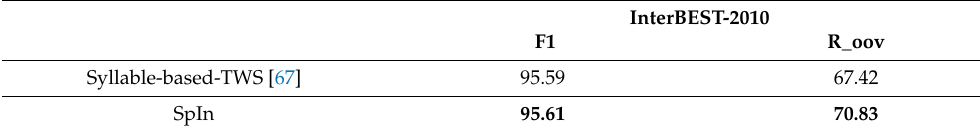
Table 6. Comparison between SpIn and previous state-of-the-art methods on the TWS